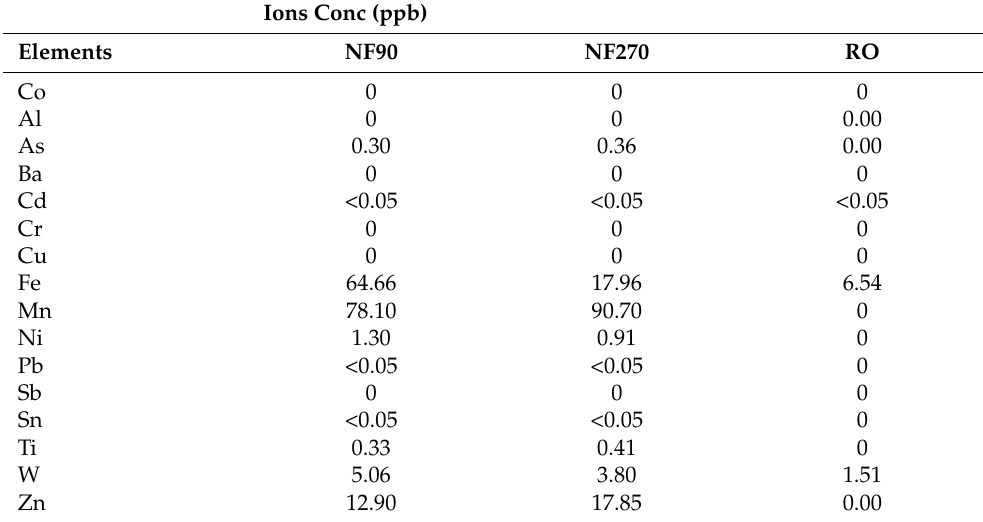
Table 5. Ion concentrations in permeate.